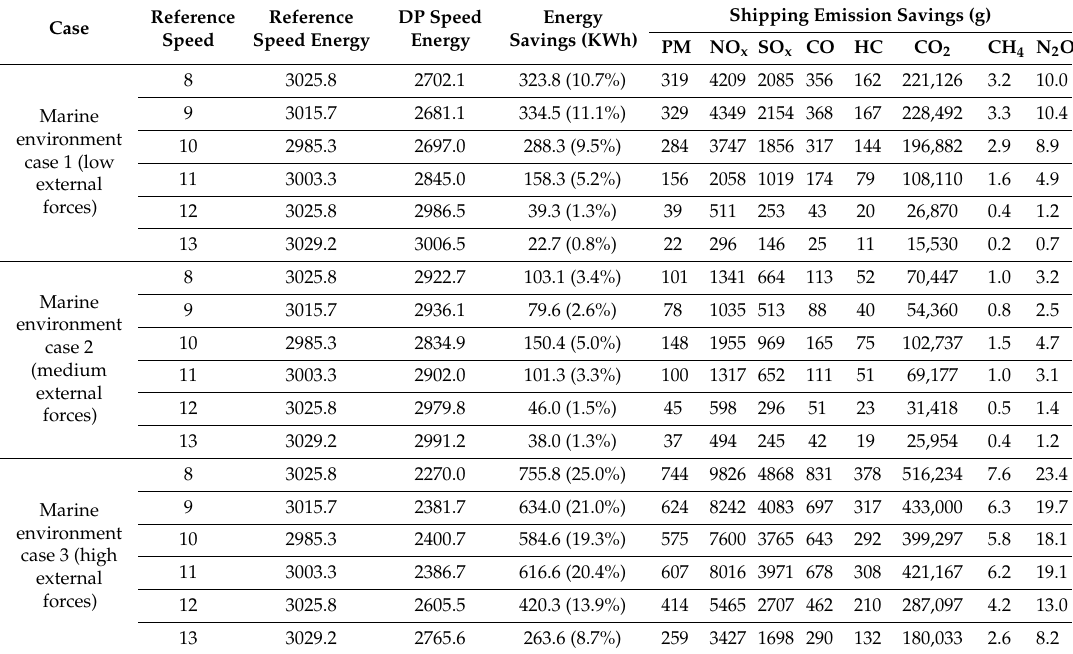
Table 6. Energy saving and emission